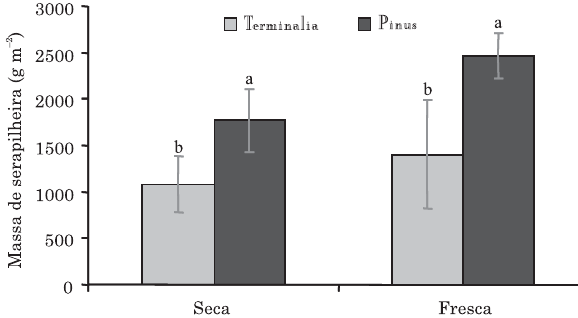
Figura 1. Massa da serapilheira seca e fresca acumulada nos povoamentos de Terminalia ivorensis e Pinus elliottii . Barras seguidas por uma mesma letra não diferem estatisticamente entre si pelo teste F (p < 0,03). Os desvios estão representados por barras